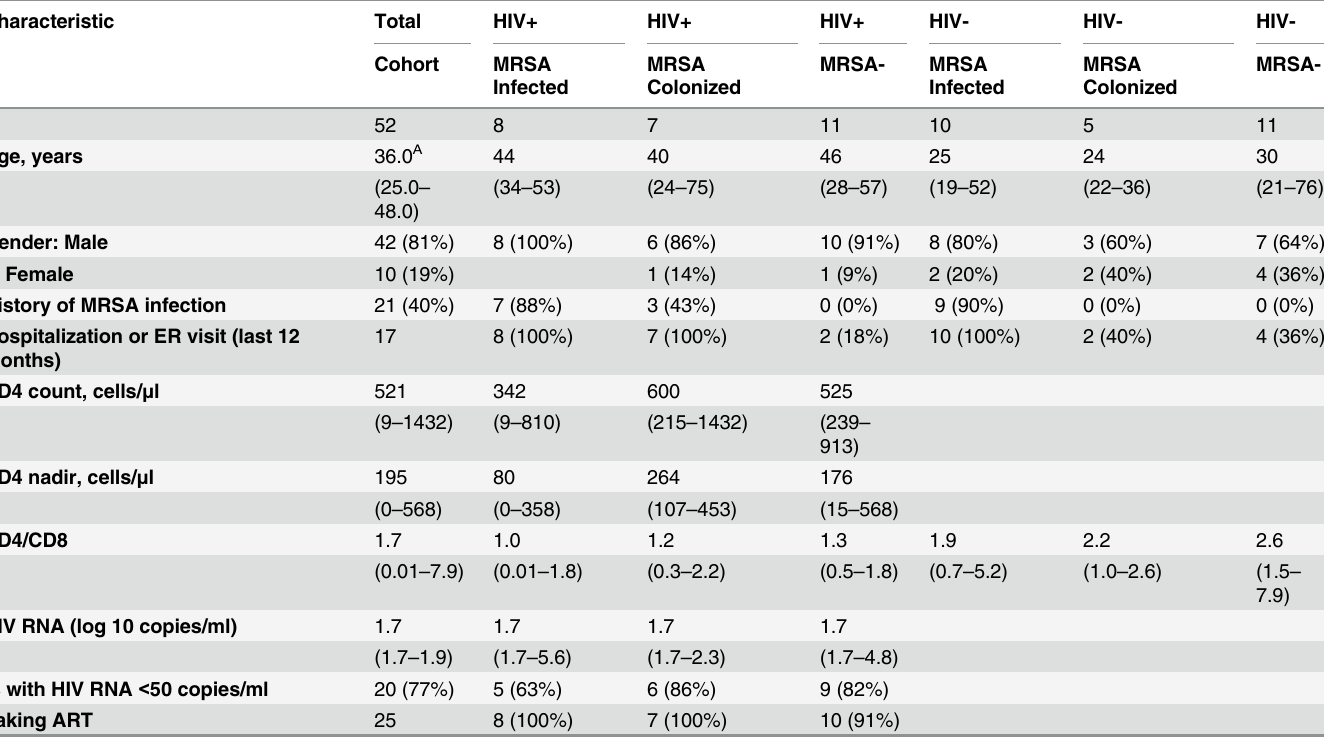
Table 1. Baseline